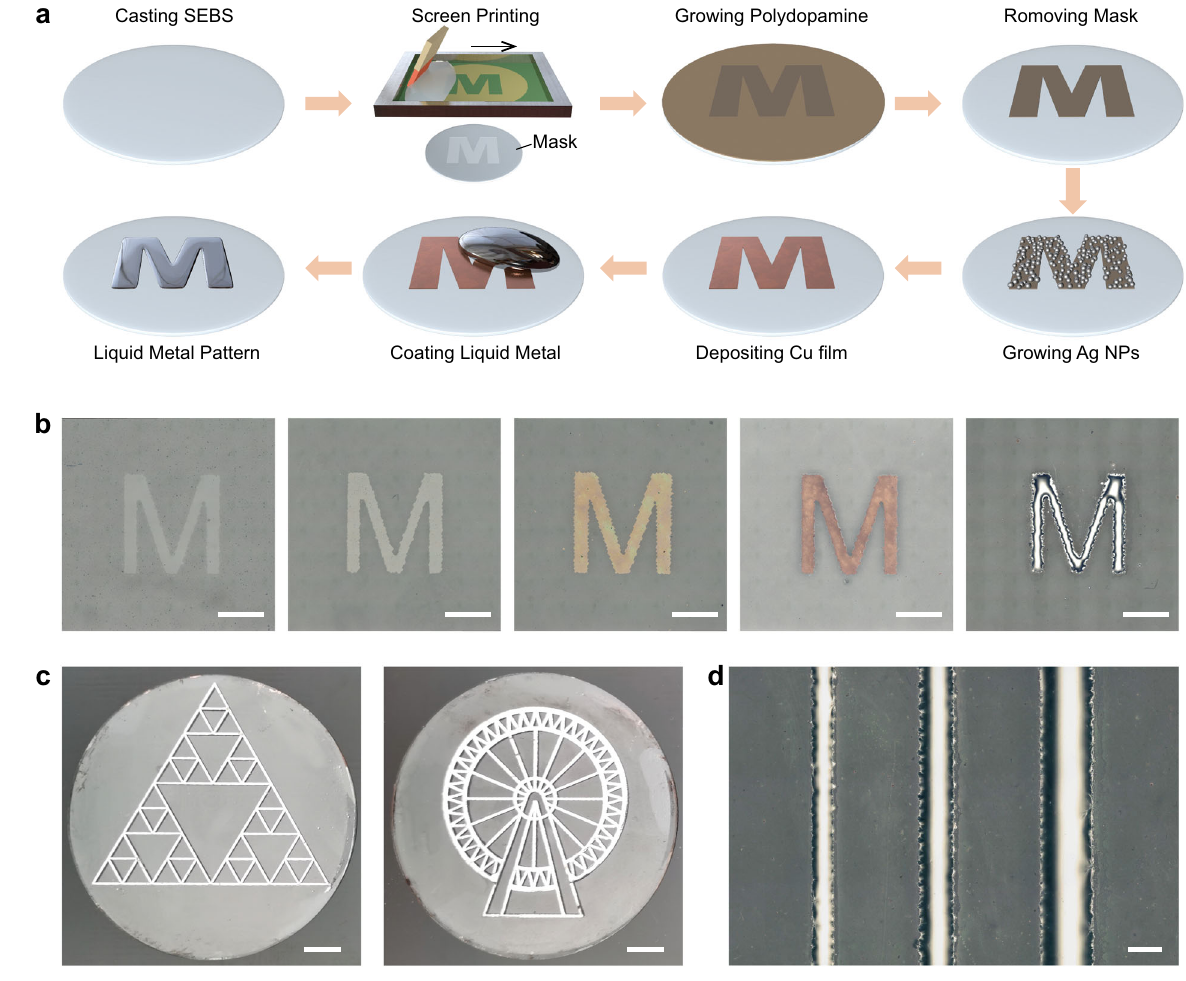
Fig. 1 Liquid metal patterning via solution-based processes. a Schematic illustration of the process fl ow to create patterned liquid metal on SEBS elastomer substrate. b Corresponding optical microscopy images at the key steps including (from left to right) screen-printed shadow mask, patterned polydopamine (PDA) layer, deposited Ag nanoparticles (NPs), electroless plated Cu fi lm, and liquid metal pattern. Scale bar: 1 mm. c Optical images of as-prepared liquid metal patterns in the shape of Sierpinski triangle (left) and sky wheel (right) on SEBS substrates. Scale bar: 1 cm. d Optical microscopy image of an array of line-shaped patterns to reveal the feature resolution. Scale bar: 200 μ